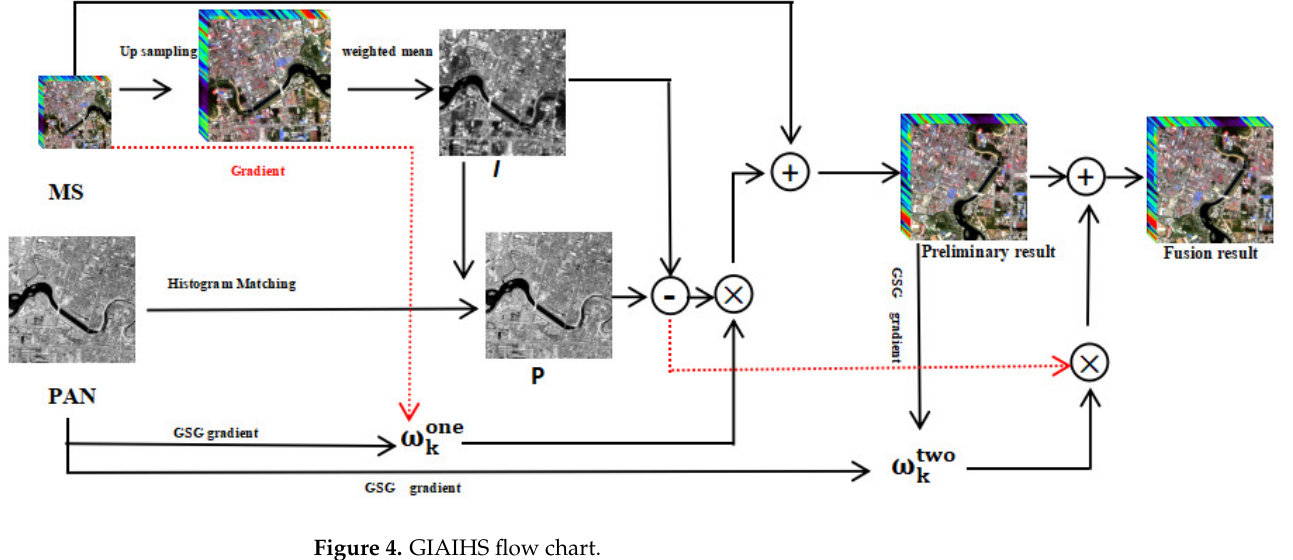
Figure 4. GIAIHS flow